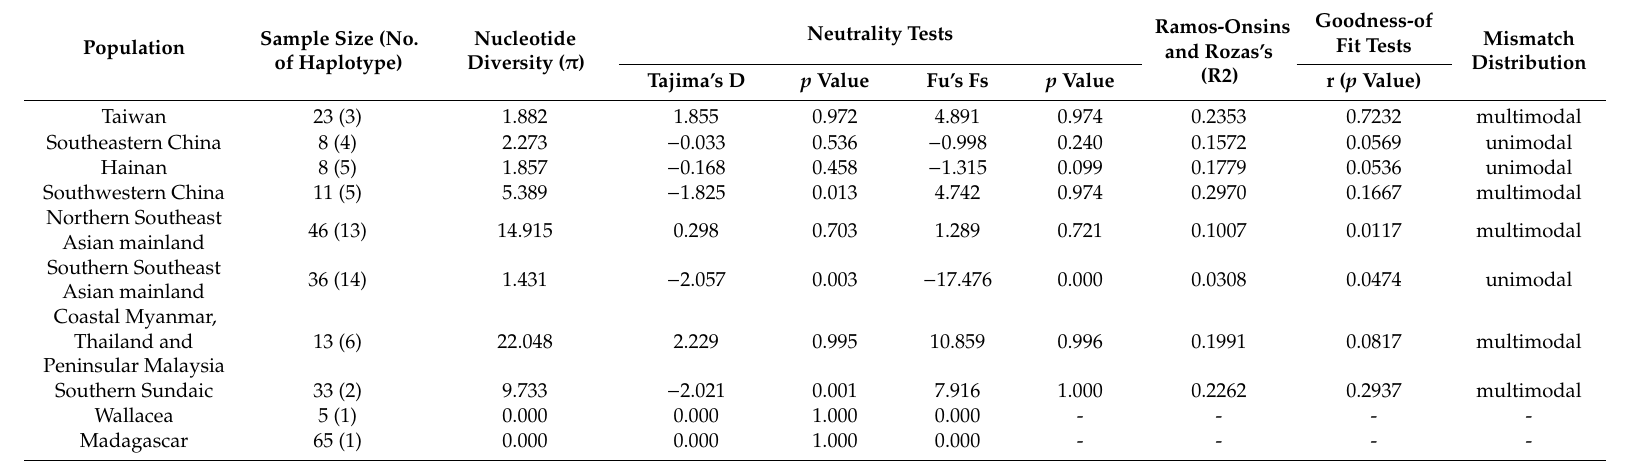
Table 2. Population genetic analyses and test of population expansion on eight populations of D. melanostictus distributed in Indomalayan realm. The analyses consist of nucleotide diversity ( π ), haplotype diversity (Hd), Neutrality Test; Tajima’s D, Li and Fu statistic, Ramos-Onsins and Roza’s (R2), Raggedness (r) and mismatch distribution for Duttaphrynus melanostictus based on 363 sequences of mtDNA tRNA